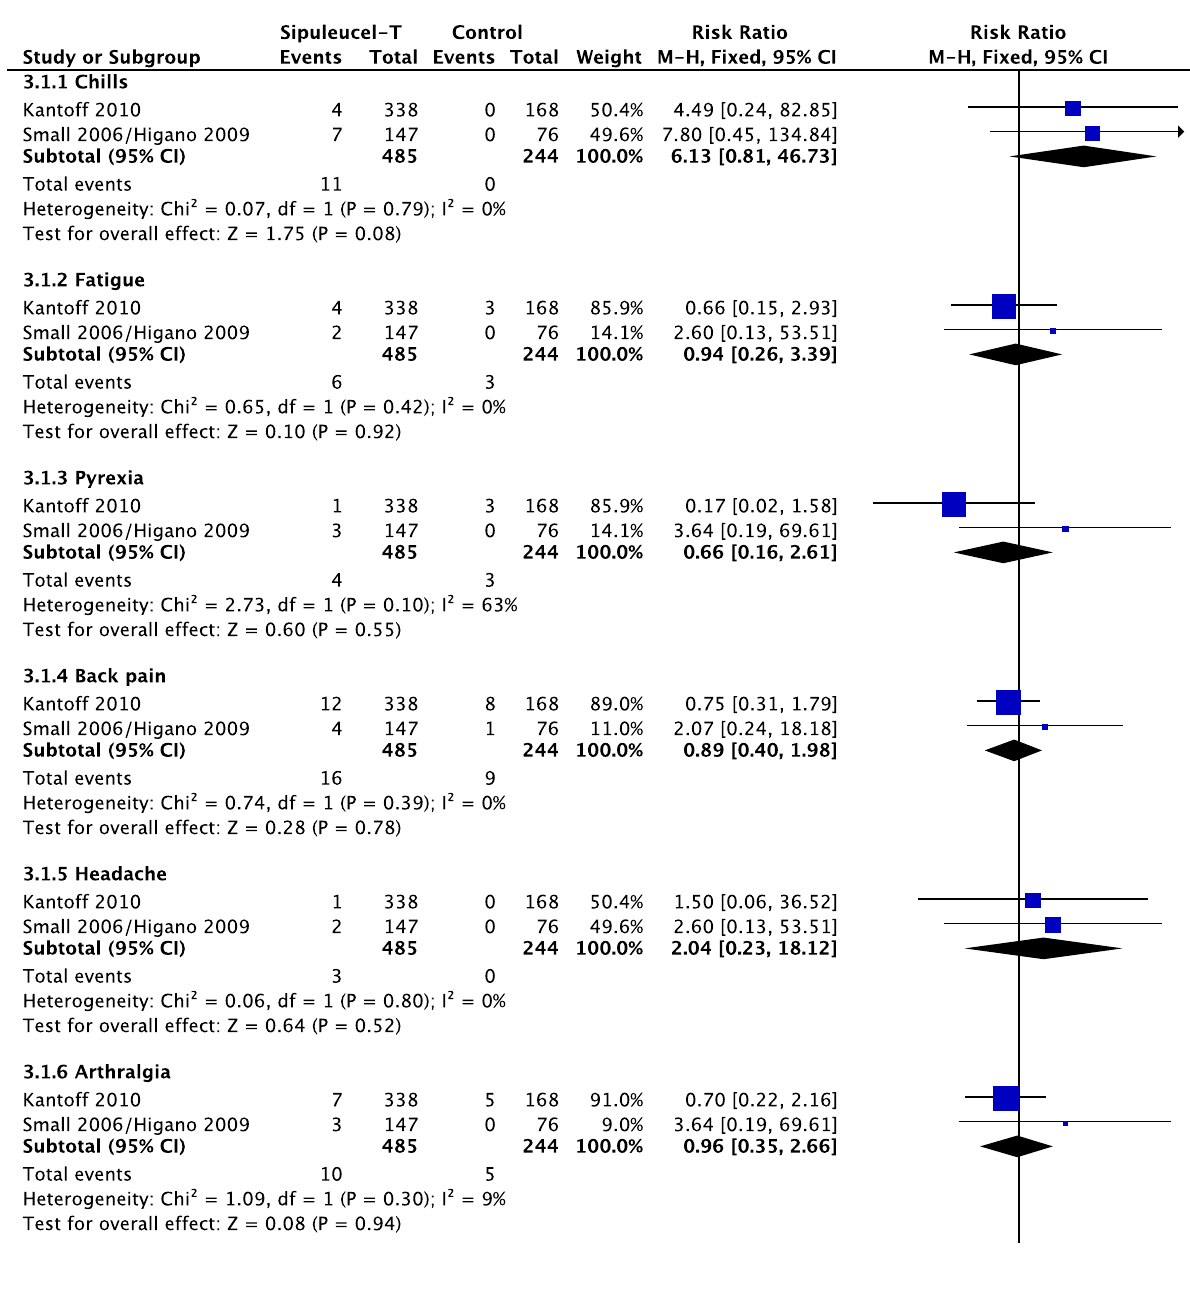
Figure 5 - Adverse events (grade > 3) of patients treated with Sipuleucel-T versus Placebo.